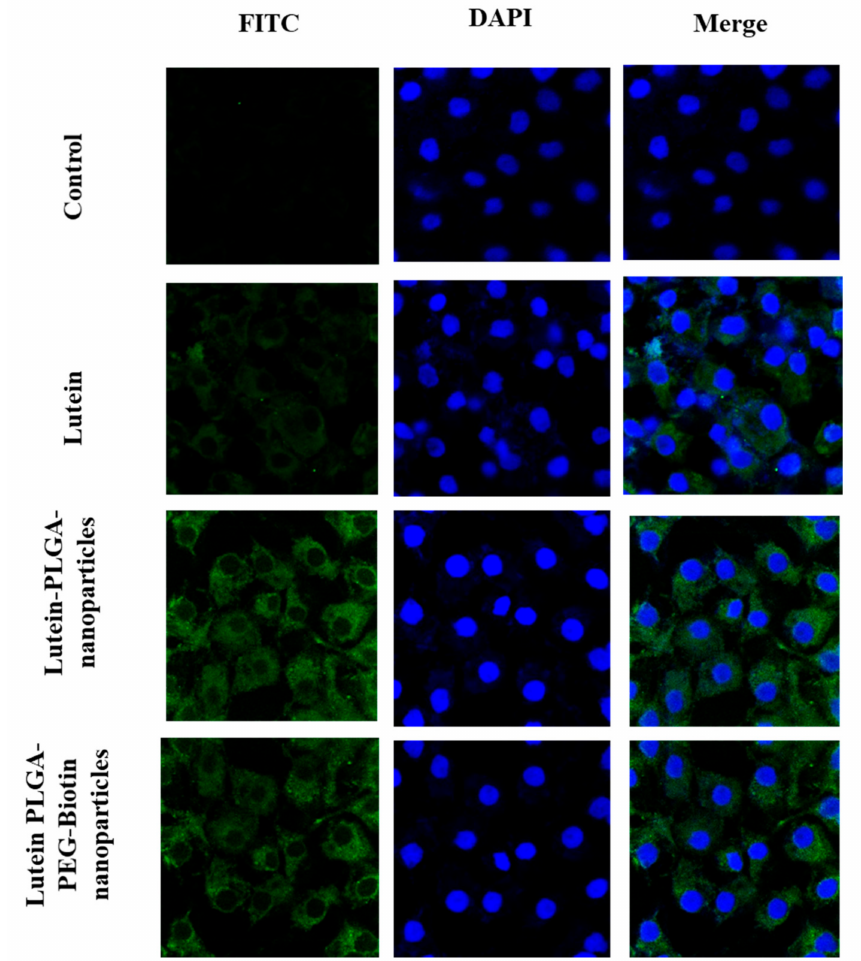
Figure 7. Confocal laser scanning microscopy images of FITC-labelled lutein and FITC-labelled lutein polymeric nanoparticles (PLGA and PLGA–PEG–biotin) at 6 h in ARPE-19